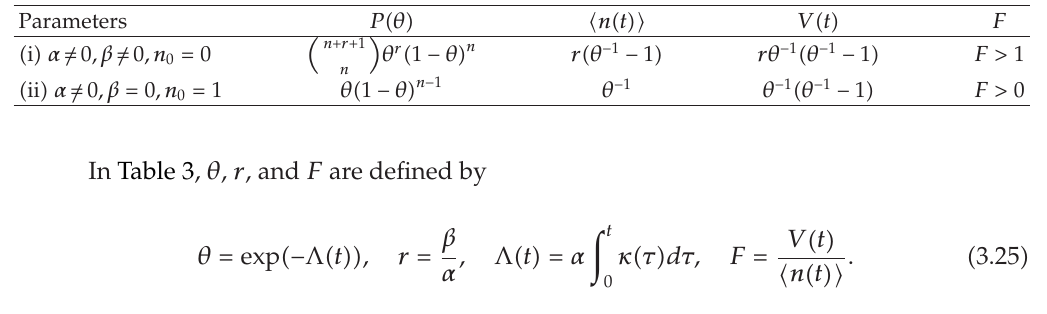
Table 3: Summary of the generalized Polya and non-stationary Yule-Furrey